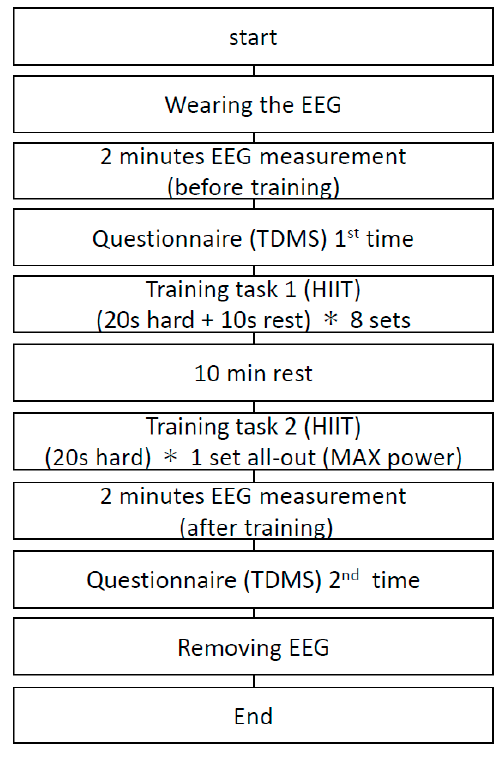
Figure 1. Experimental procedure.